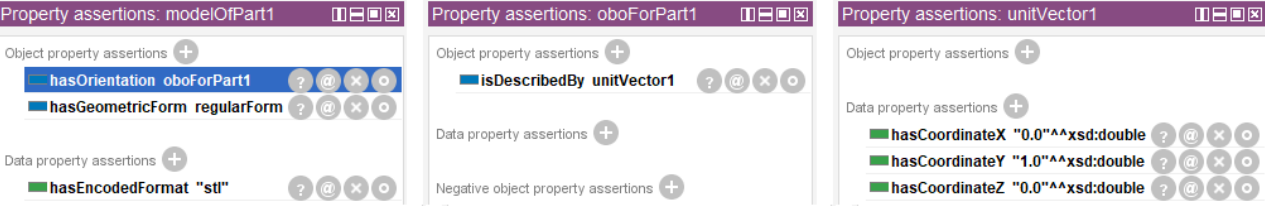
Figure 10. Results of part orientation for the LPBF part in the ontology.